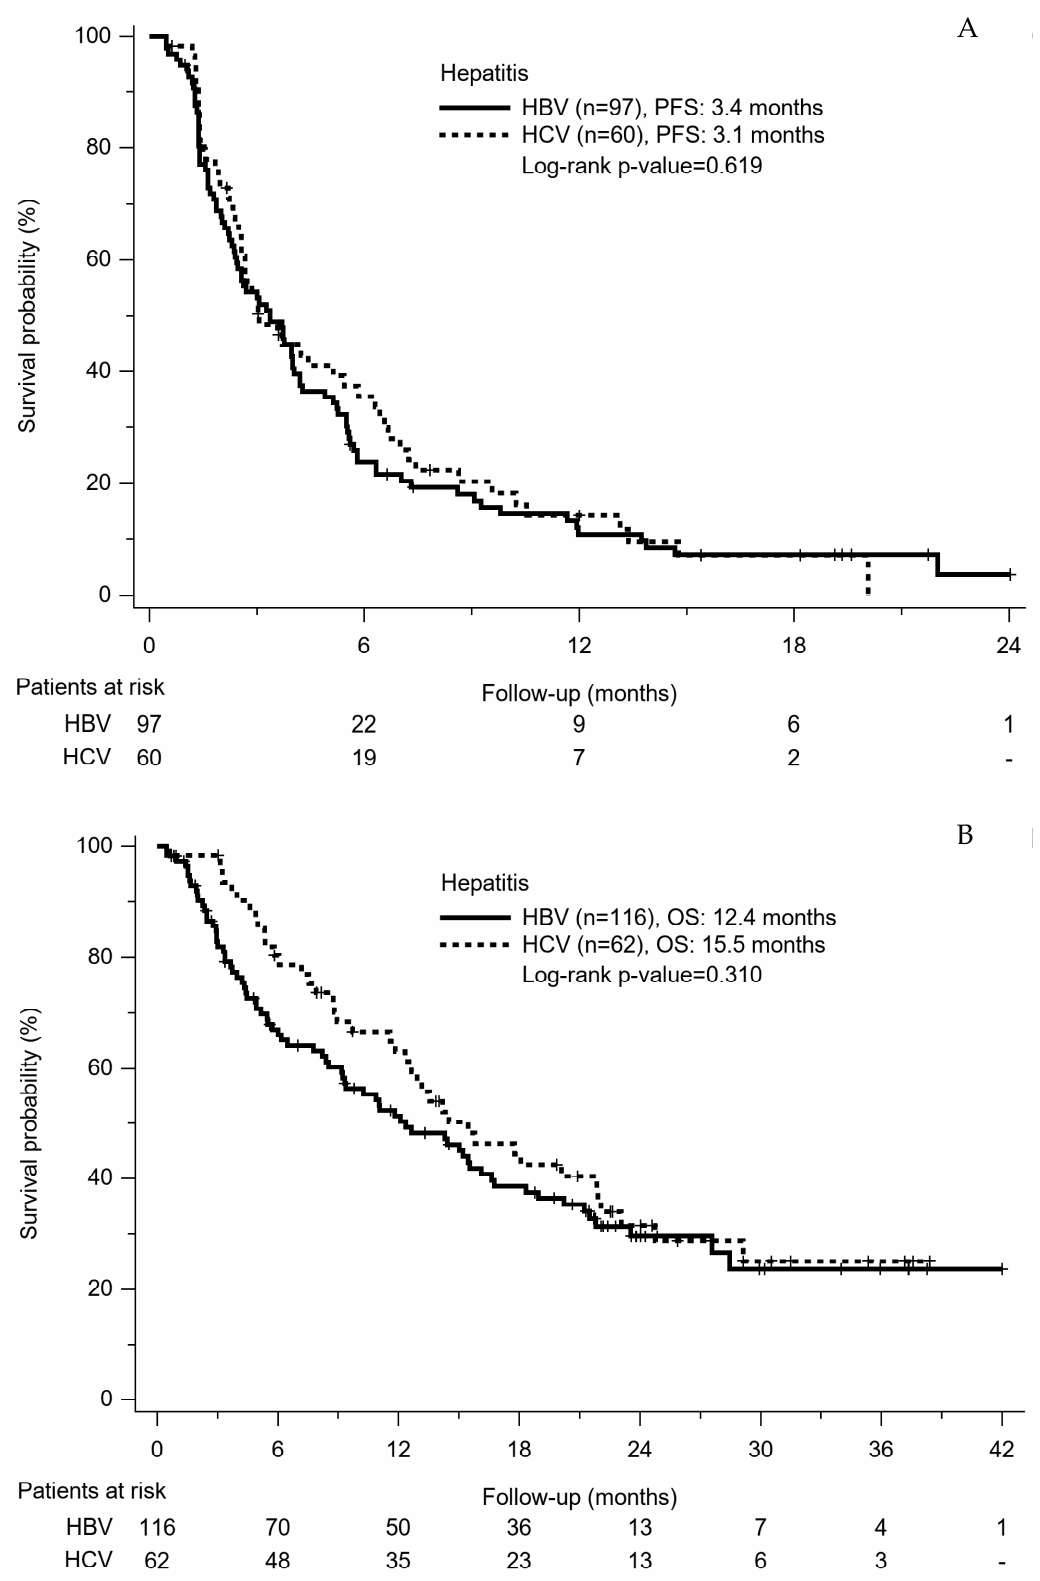
Figure 2. ( A ) Progression-free survival rates of HBV-HCC patients and HCV-HCC patients. ( B ) Overall survival rates of HBV-HCC patients and HCV-HCC